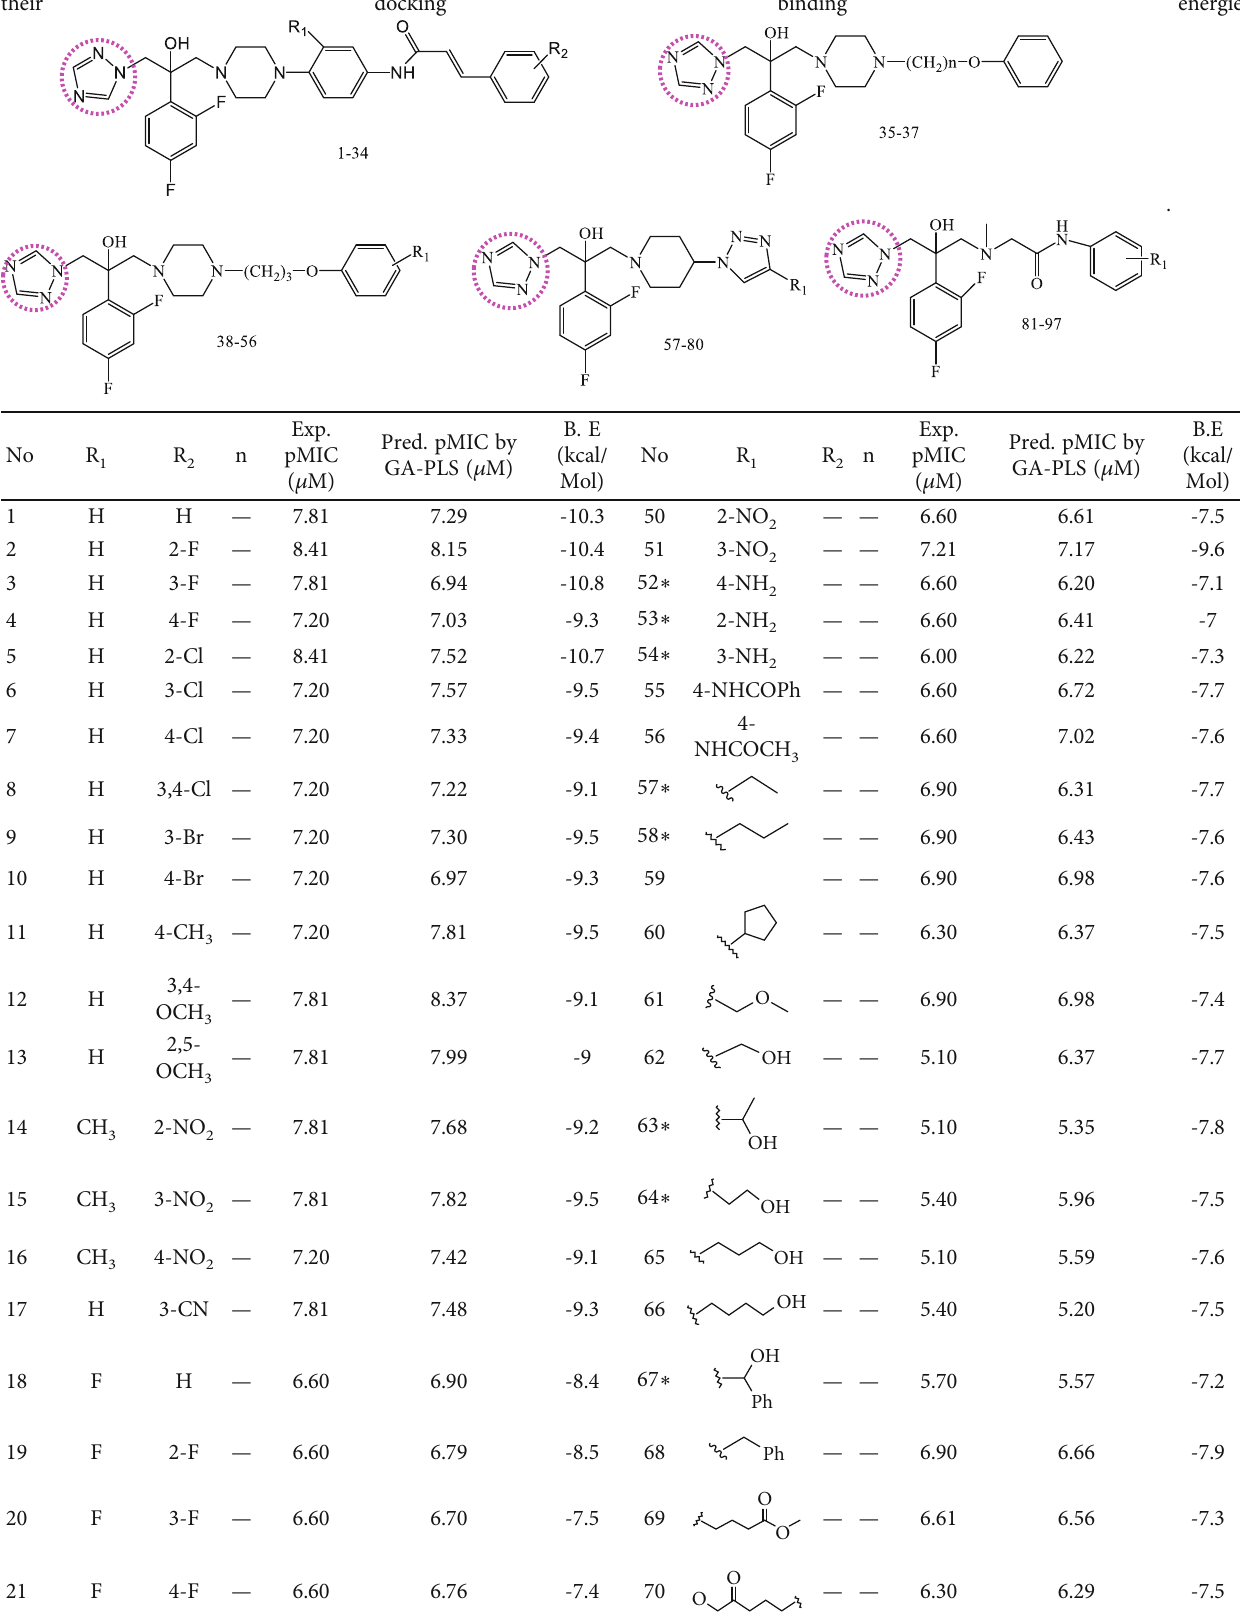
Table 1: Chemical structure of fl uconazole like compounds and their experimental and cross validated-predicted activity by (GA-PLS) and their docking binding energies